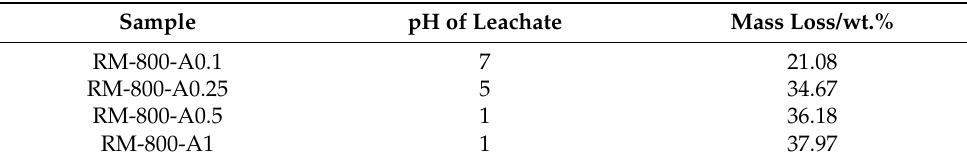
Figure 7. SEM-EDS analysis of RM-800 ( a ) and RM-800A0.1 ( b ).